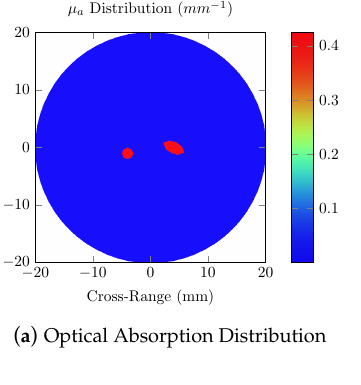
Figure 2. Total optical fluence distribution inside the homogeneous phantom with two absorbers using an 800 nm source. The circular and elliptical absorbers, simulating hemoglobin with absorption coefficient µ a = 0.425 mm − 1 at 800 nm, are located 4 mm to the left and right of the center. The background has a µ a = 0.001 mm − 1 , and a reduced scattering coefficient µ (cid:48) s = 1 mm − 1 . µ (cid:48) s = 0 for the absorbers.